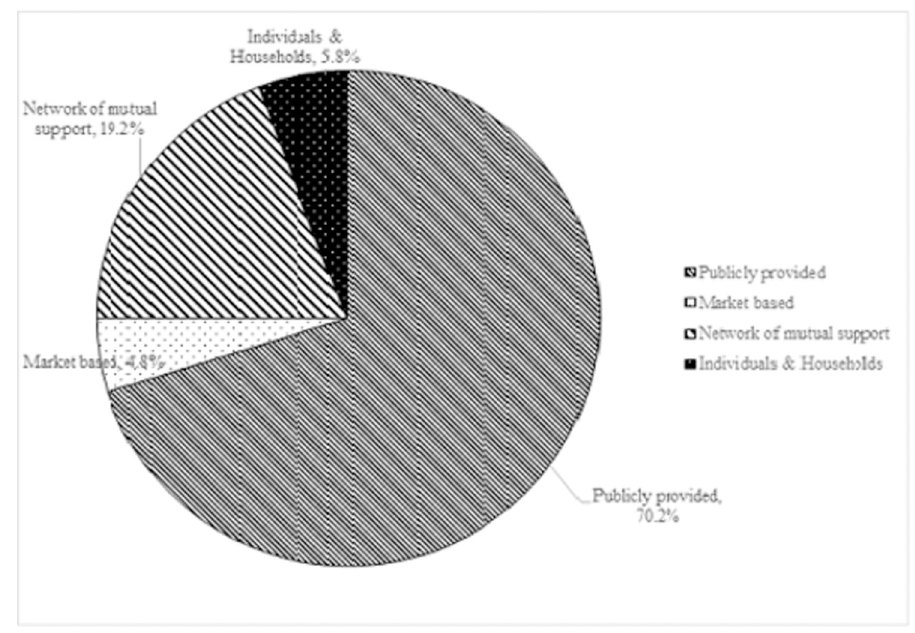
Fig 3. Patient cost coping